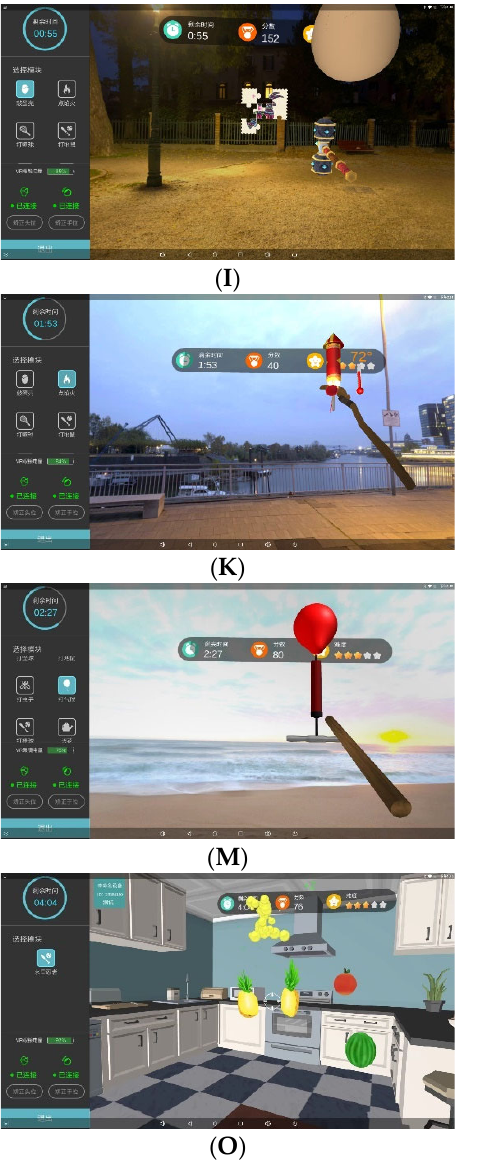
Figure 1. A total of 16 training items were available for researchers and individuals. ( A – D ) Life skills: cooking ( A ), cleaning a window ( B ), crossing a road ( C ), and watering flowers ( D ); ( E – H ) exergames: playing squash ( E ), shooting antiaircraft guns ( F ), flying gliders ( G ), and playing baseball ( H ); ( I – P ) entertaining games: breaking eggshells ( I ), swatting insects ( J ), lighting fireworks ( K ), whack ‐ a ‐ mole ( L ), pumping up a balloon ( M ), flying a Kongming lantern ( N ), Fruit Ninja ( O ), and Bubble Jab ( P ),